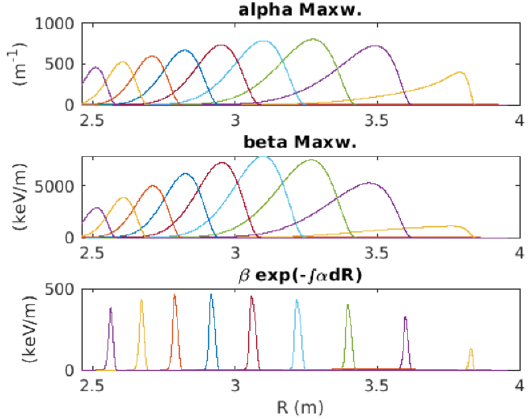
Fig. 2. 2 nd harmonic EC absorption, emission coefficients and radiation function 𝛽𝑒𝑥𝑝 (− ∫𝛼𝑑𝑅) for a Maxwellian plasma and JET parameters. T e = 10